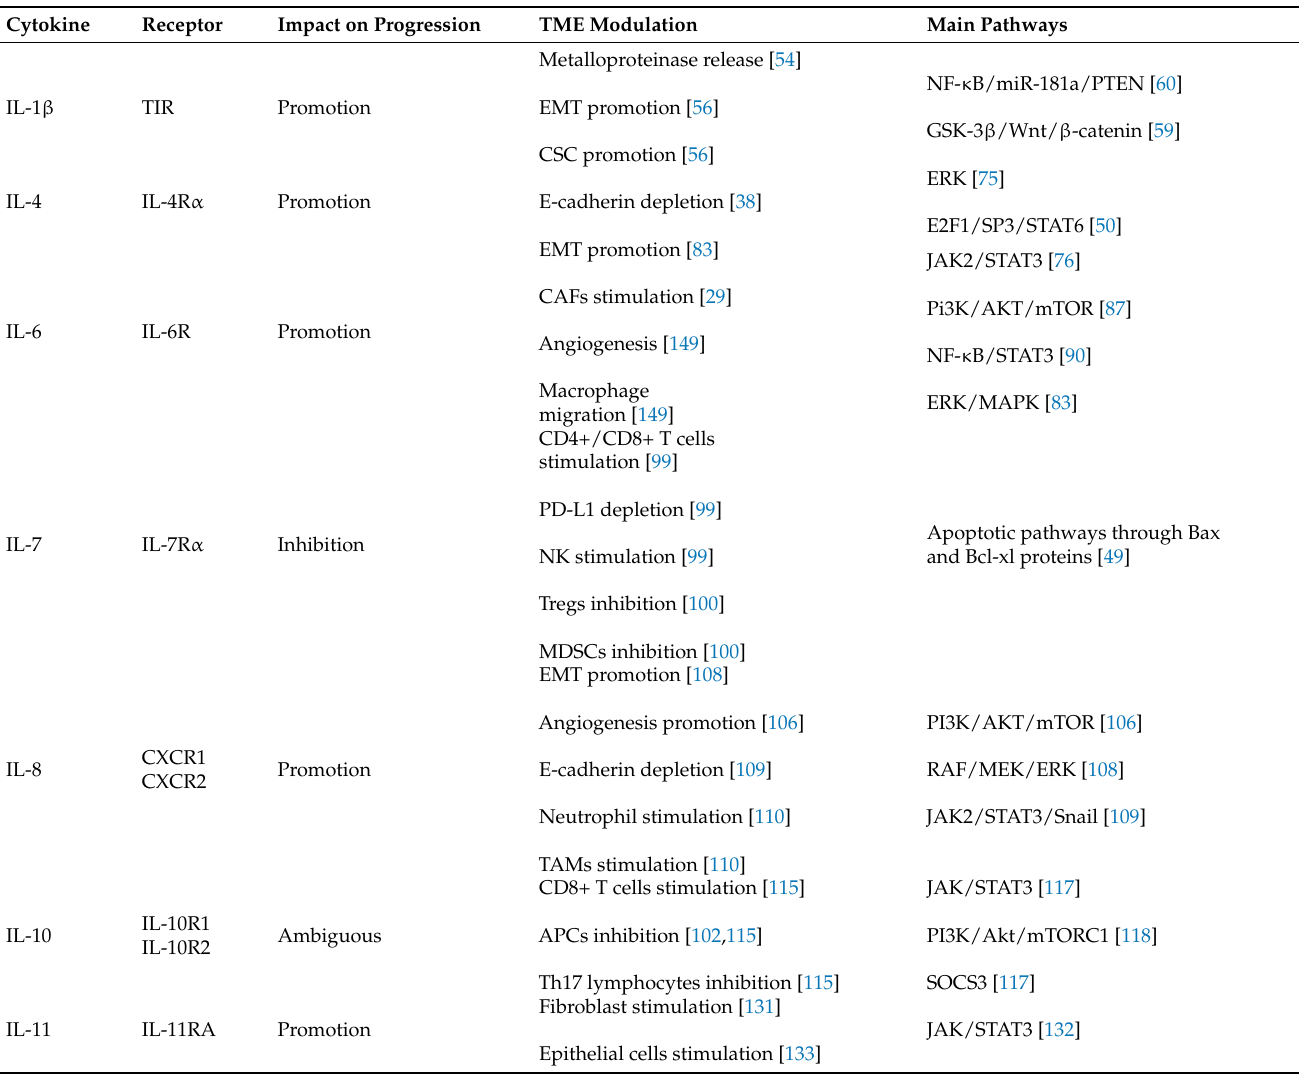
Table 2. Summarized role of cytokines in the pathogenesis of